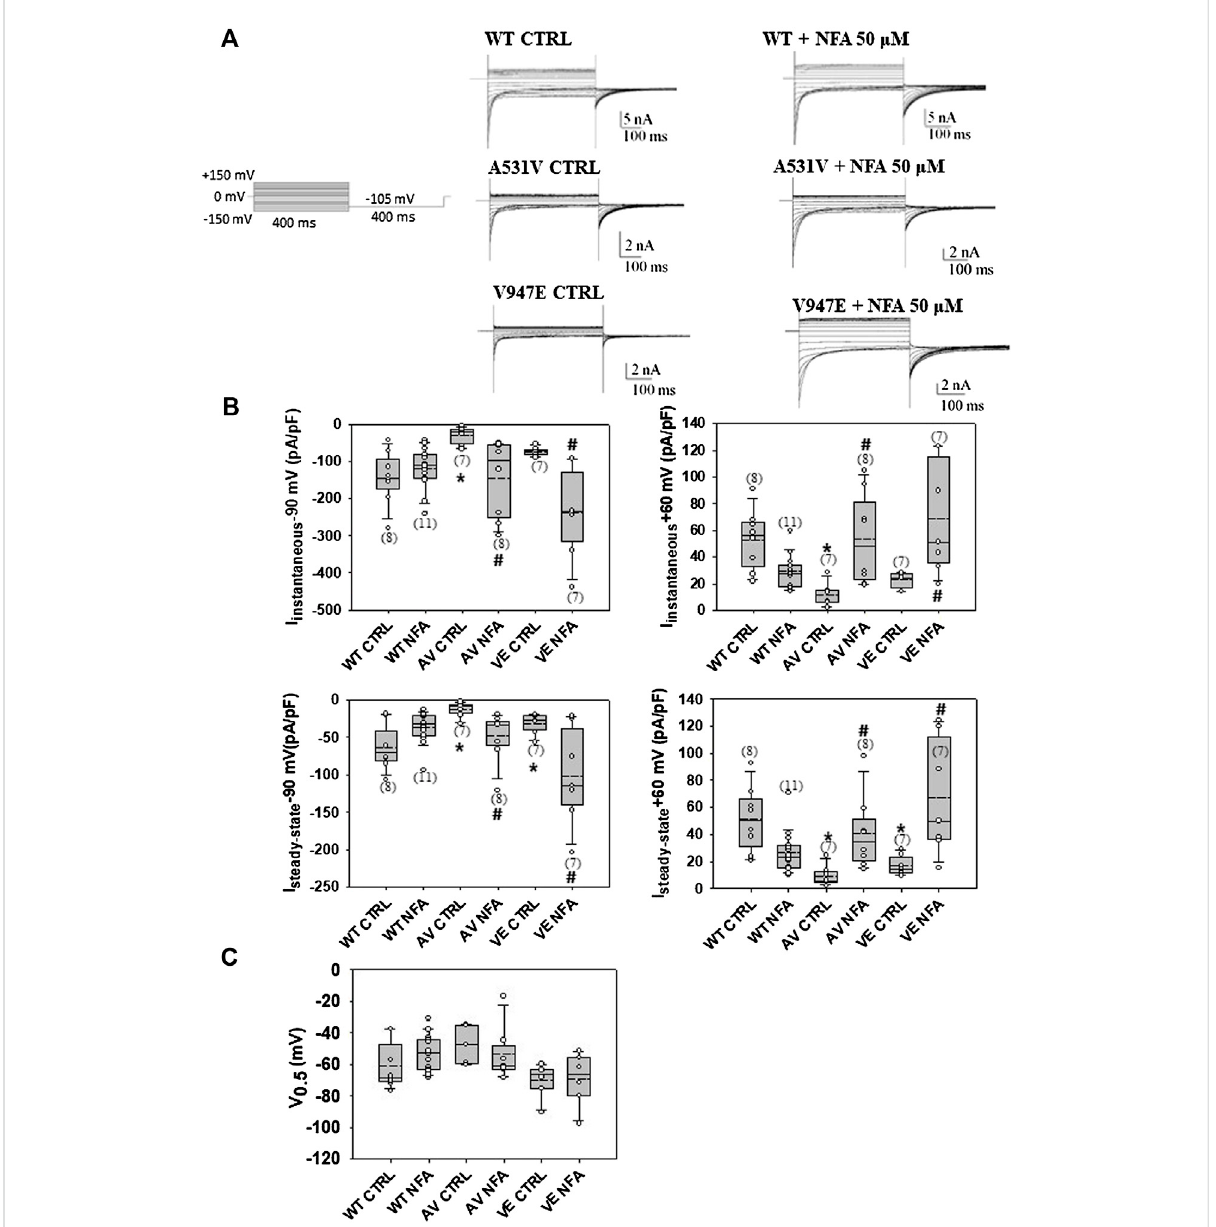
FIGURE 2 Chaperone effect of NFA on WT, A531V, and V947E ClC-1 chloride channels. (A) . Representative traces of WT, A531V, and V947E chloride currents before and after the incubation of 50 µM NFA for 24 h. (B) . Values of instantaneous and steady-state chloride currents of WT, A531V, and V947E mutants measured at − 90 and +60 mV before and after the incubation with NFA 50 µM. (C) . Values of V 0.5 (half-maximal activation potential) of WT, A531V, and V947E channels before and after the incubation of NFA. Each dot represents the V 0.5 value obtained from a single recording. Data areshown asbox-and-whisker plots. Median(solid line);mean(dashline);and 10th,25th,75th,and 90th percentilesare indicated. Thenumber of examined cells is reported in brackets. (*at least p < 0.05 vs WT CTRL, # at least p < 0.05 vs its relative